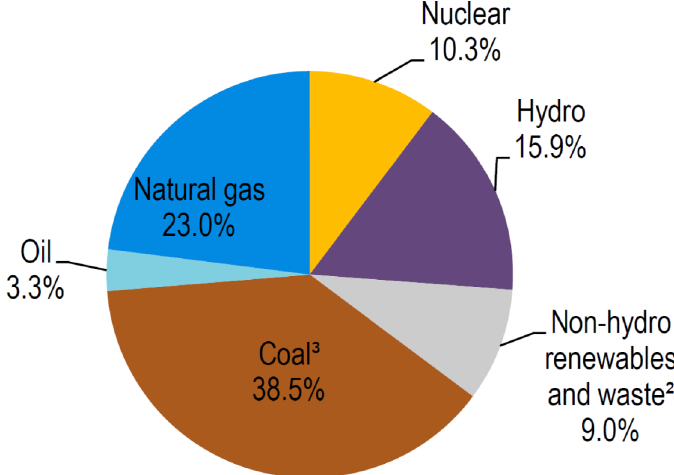
Fig. 9. – World electricity generation (2017) [7] ( c (cid:2) OECD/IEA